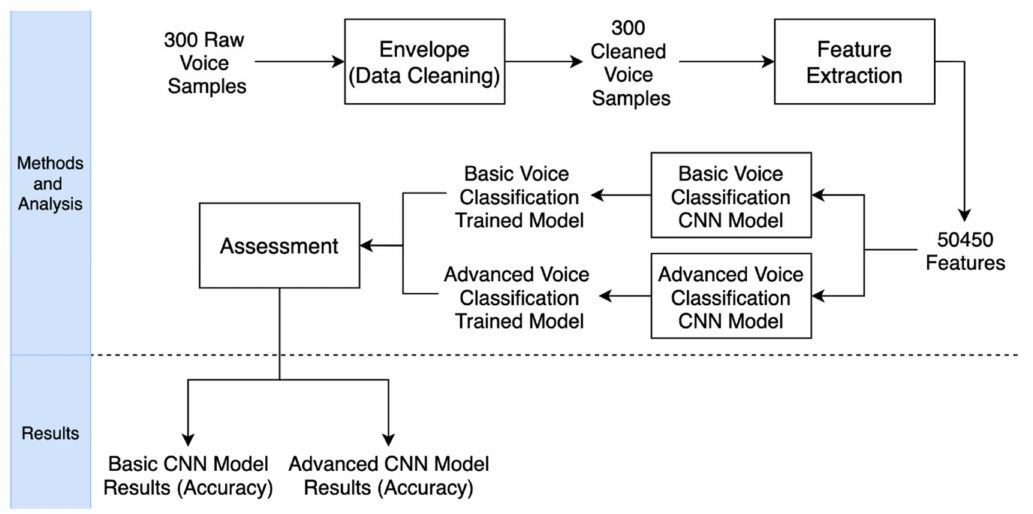
Figure 1. Pipeline for preprocessing and development of voice classification